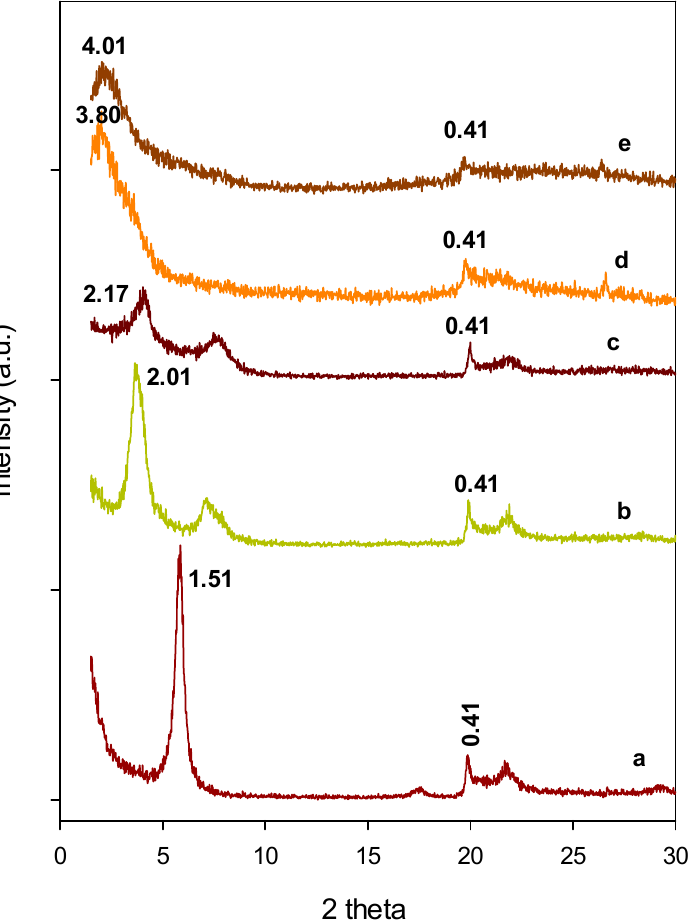
Figure 1. Powder XRD patterns of ( a ) starting Ca-Mt, ( b ) Al-Mt, ( c ) Zr-Mt, ( d ) Al-PCH, and ( e ) Z- PCH precursors.